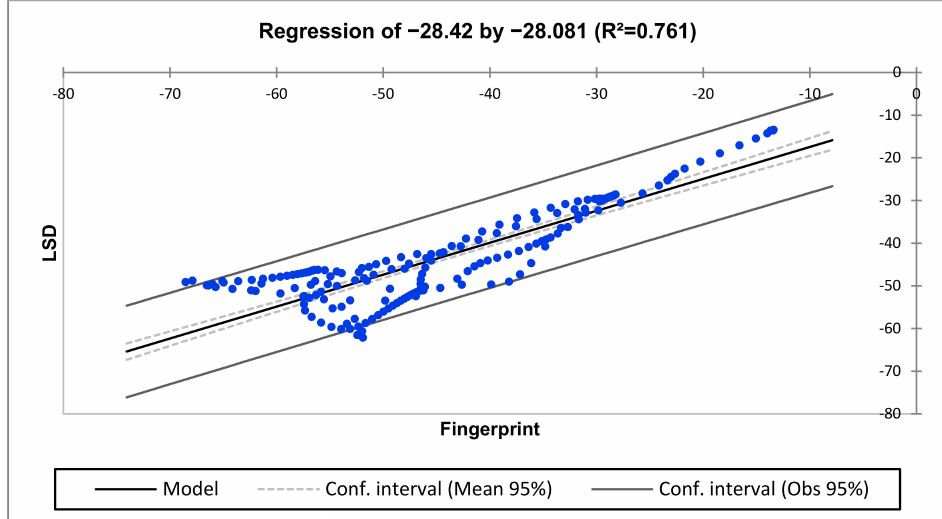
Figure 22. Regression for H2-H1 vs. H3-H2 (medium-frequency region). For Case IV, the equation of the model at each frequency region for all the compared phases indicates that when the fingerprint increases by one hertz, the LSD increases by 1.021, 1.017 and 1.0929 at lower-, medium- and high-frequency regions, respectively, in the range of variable fingerprint that is taken into account here, when the phases H1H3 and H2H1 are compared. A similar observation is made when comparing the H2H1 vs. H3H2 phases as well as the H3H2 vs. H1H3 phases, where the LSD increases by 0.976, 0.748 and 0.758 and 1.003, 1.024 and 1.1022, respectively. Here the obvious deformation is observed when comparing H2H1 vs. H3H2 phases. The CC and ASLE appear to agree with this assessment. Upon internal inspection, the winding was found to have a buckled winding deformation on